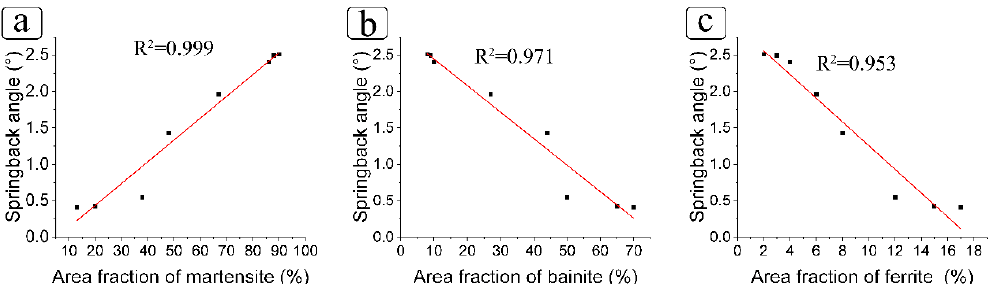
Figure 7. The relationship between the springback angle and area fractions of the quenched phases.